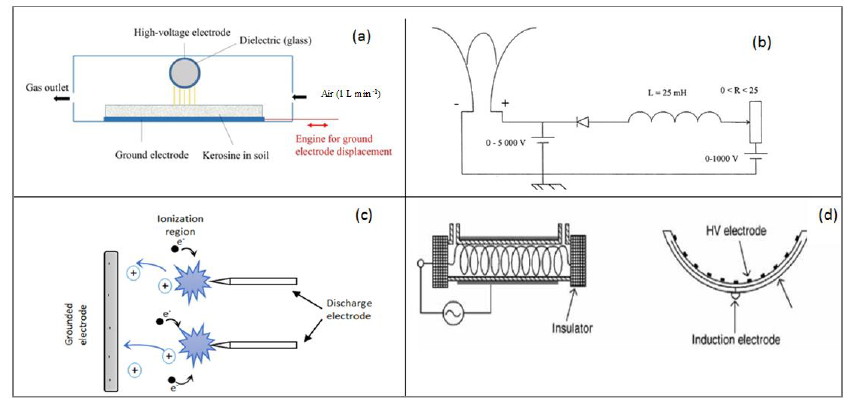
Figure 1. Typical scheme of the main plasma reactor configuration: ( a ) Dielectric barrier discharge [35], ( b ) Gliding arc gas discharge [38], ( c ) corona discharge [44], ( d ) surface discharge reactor [45].